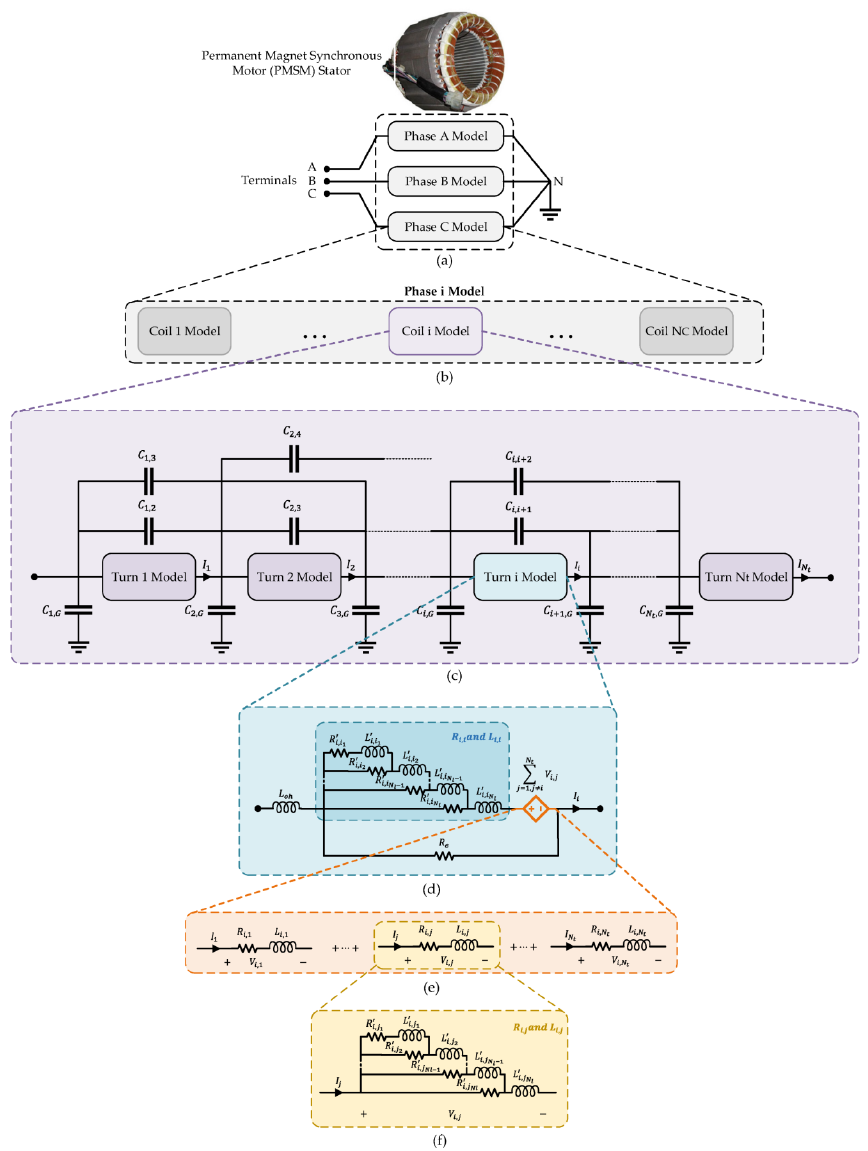
Figure 8. The MCTL model of PMSM stator windings; ( a ) stator model; ( b ) phase model; ( c ) coil model; ( d ) turn model; ( e ) elements of controlled voltage source in turn model; ( f ) ladder circuits to model frequency-dependent resistances and inductances.